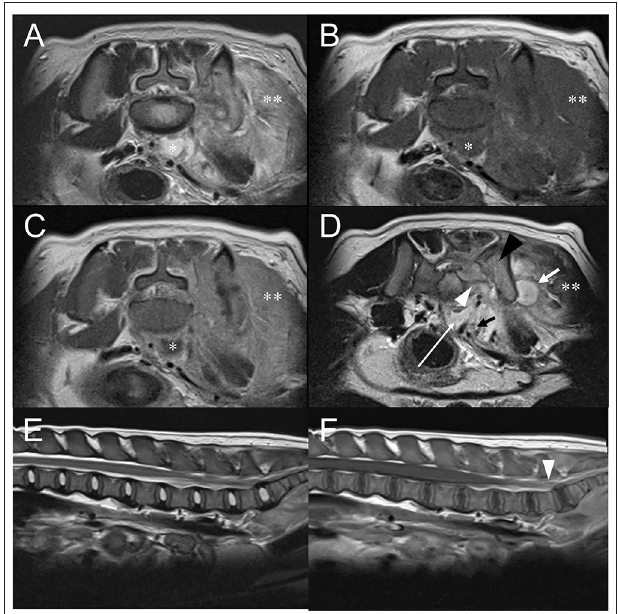
FIGURE 3 | Transverse T2W image (A) , pre-contrast T1W image (B) , post-contrast T1W image (C) at the level of L7-S1 intervertebral space and T2W image (D) at the level of sacroiliac joint. Sagittal T2W image (E) of the lumbar spinal cord and post-contrast T1W images (F) of the lumbar spinal cord. (A–C) T2W hyperintense, T1W hypointense, and contrast-enhanced T1W rim enhancing structure (asterisk) located at ventral of the lumbar vertebral body represents retroperitoneal abscess. (D) Retroperitoneal abscess (white long arrow) is found at the level of sacroiliac joint. Muscular abscess (white short arrow) is also indicated. Compared to the right sacral bone, left sacral (white arrowhead) and iliac bone (black arrowhead) are T2W hyperintense and indistinct left sacroiliac joint space, which is consistent with sacroiliitis. Left gluteal, sacrocaudal, and sublumbar muscle (double asterisk) show marked swelling, T2W hyperintense, and enhanced on contrast-enhanced T1W. (E) No abnormality is noted in the lumbar spinal cord of the T2W sagittal image. (F) Compared to other regions of lumbar spinal cord, mildly increased intensity of the spinal cord at the level of L7-S1 is shown (arrowheads) at post-contrast T1W. This could represent true enhancement but also could be due to slice thickness